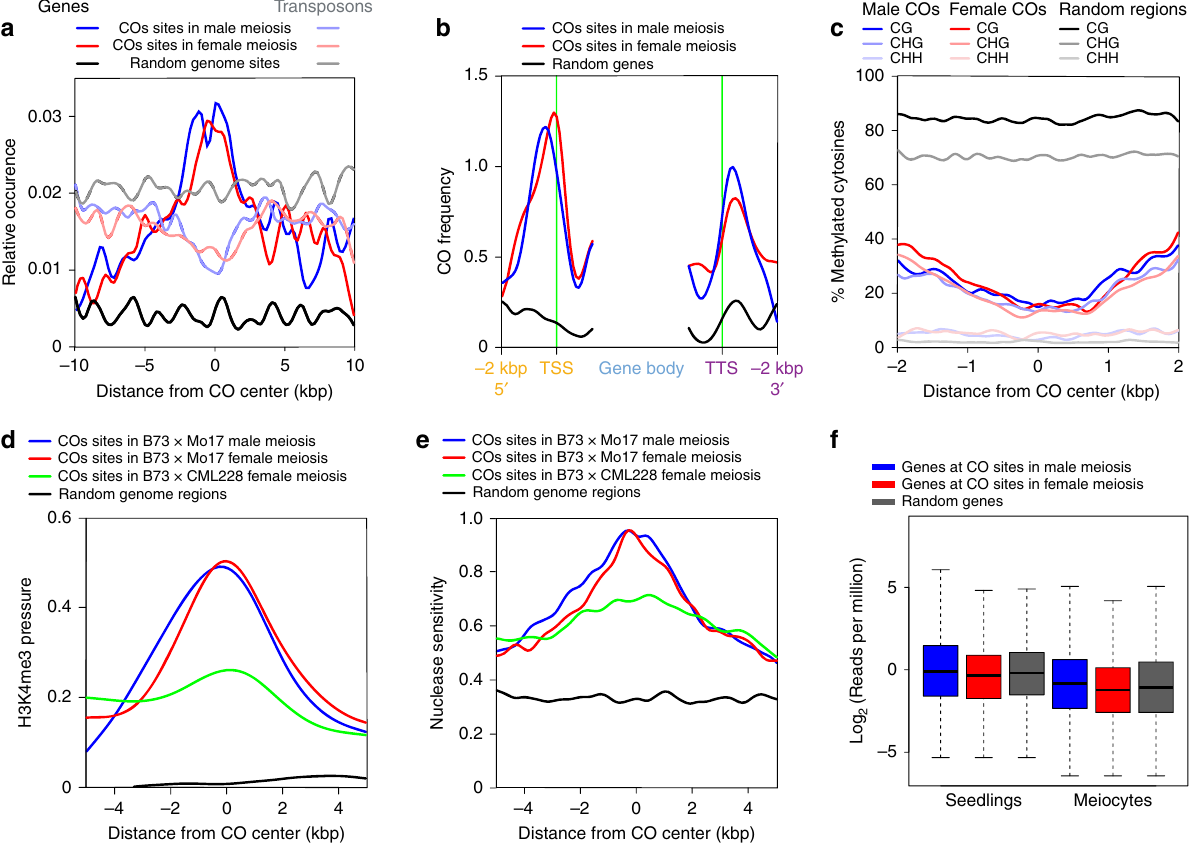
Fig. 3 Relationship of COs sites to genome and chromatin features in male and female meioses. a Position of COs relative to TEs and protein coding genes. b Position of COs in the 5 ′ and 3 ′ regions of genes. c DNA methylation patterns around CO sites at CG, CHG, and CHH sites. d H3K4me3 levels of CO sites in male and female meioses. e Nucleosome occupancy of CO sites in male and female meioses measured using micrococcal nuclease sensitivity. f Boxplot showing transcription levels of CO-containing genes in male meiocytes and seedlings. Center lines of boxes represent median expression levels, bounds of boxes designate expression levels of the fi rst ( Q 1) and third ( Q 3) quartiles from top, lower whiskers are Q 1 – 1.5 × IQR, and upper whiskers are Q 3 – 1.5 ×